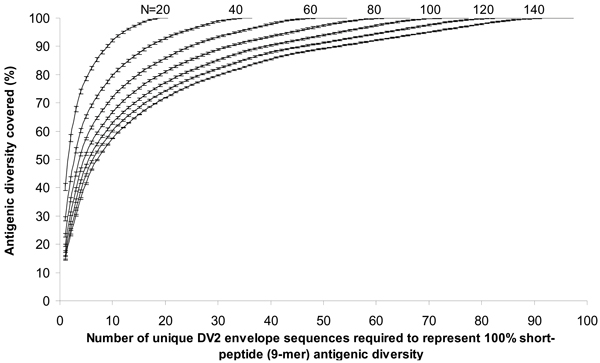
Short-peptide (9-mer) antigenic diversity as a function of number of sequences. Short-peptide antigenic diversity has an asymptotic relationship to number of unique dengue virus serotype 2 (DV2) envelope sequences (N). Each curve shows the cumulative percentage coverage of short-peptide antigenic diversity. Vertical bars represent standard error for repeated random sampling of 20 times.